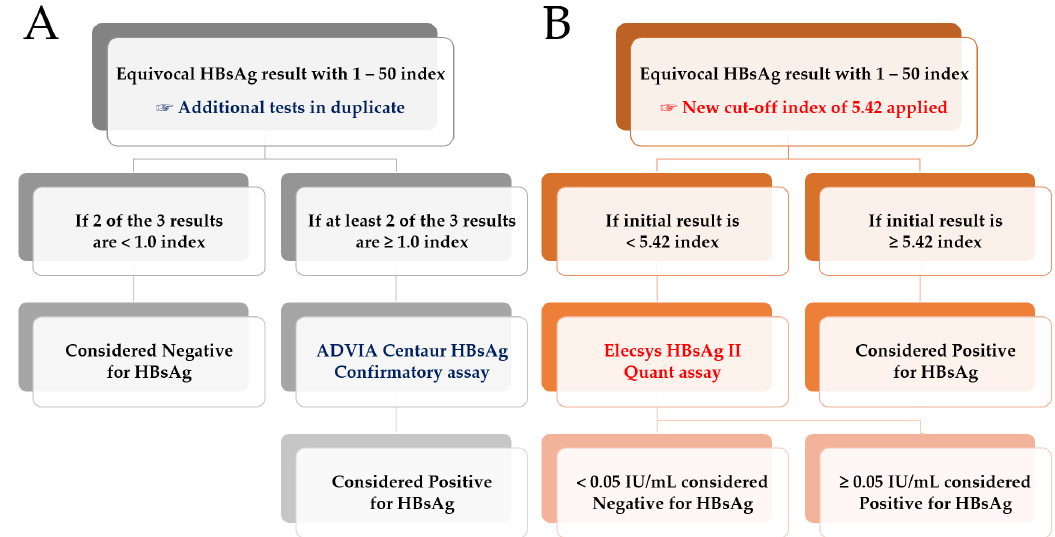
Figure 2. Comparison of the qualitative HBsAg testing strategy workflow for determining equivocal HBsAg results, as measured using the ADVIA Centaur HBsAg II assay. ( A ) Conventional strategy with duplicate tests; the ADVIA Centaur HBsAg Confirmatory assay is required if at least 2 out of 3 results are ≥ 1.0. ( B ) Proposed strategy with the new cutoff index of 5.42 without additional/duplicate tests; the Elecsys HBsAg II Quant assay is required if the initial result is <5.42.